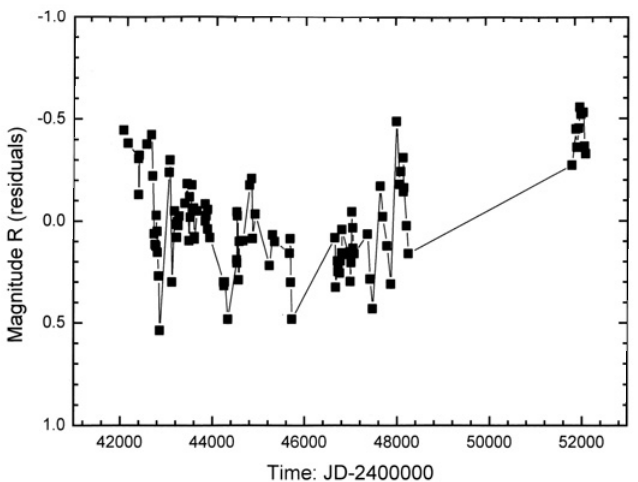
Fig. 3. Pre-whitened light curve of V637